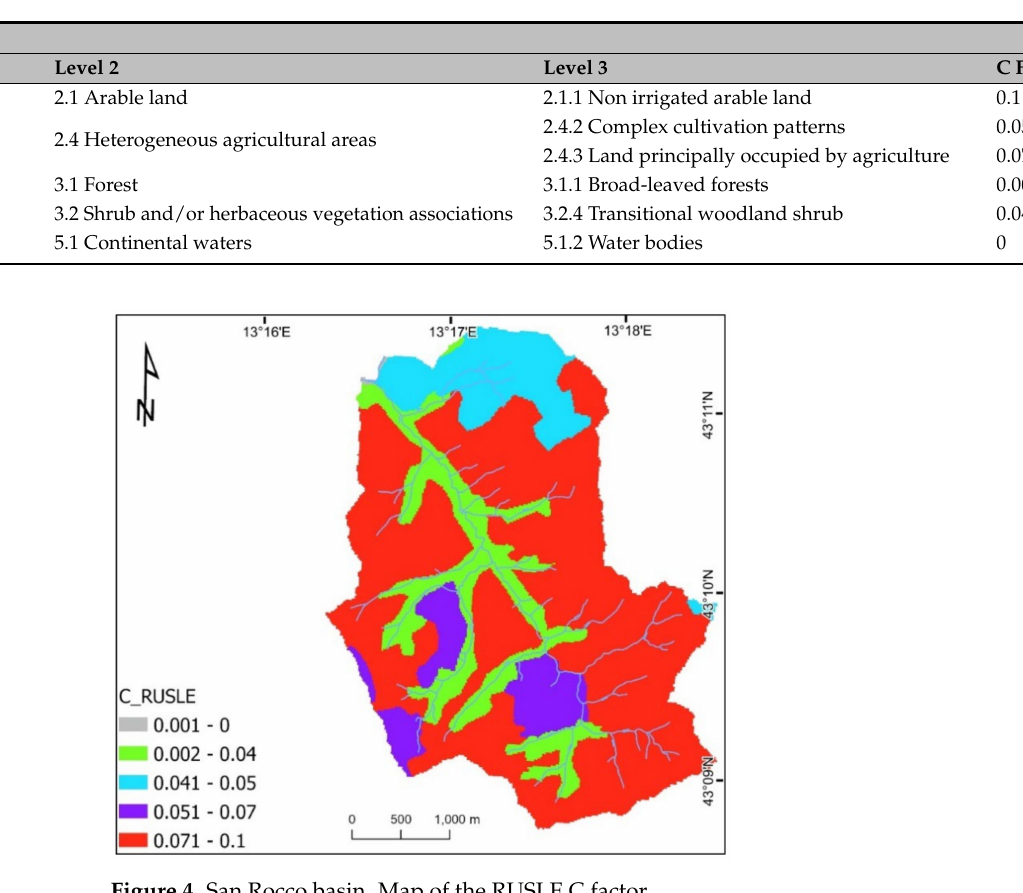
Figure 4. San Rocco basin. Map of the RUSLE C factor.